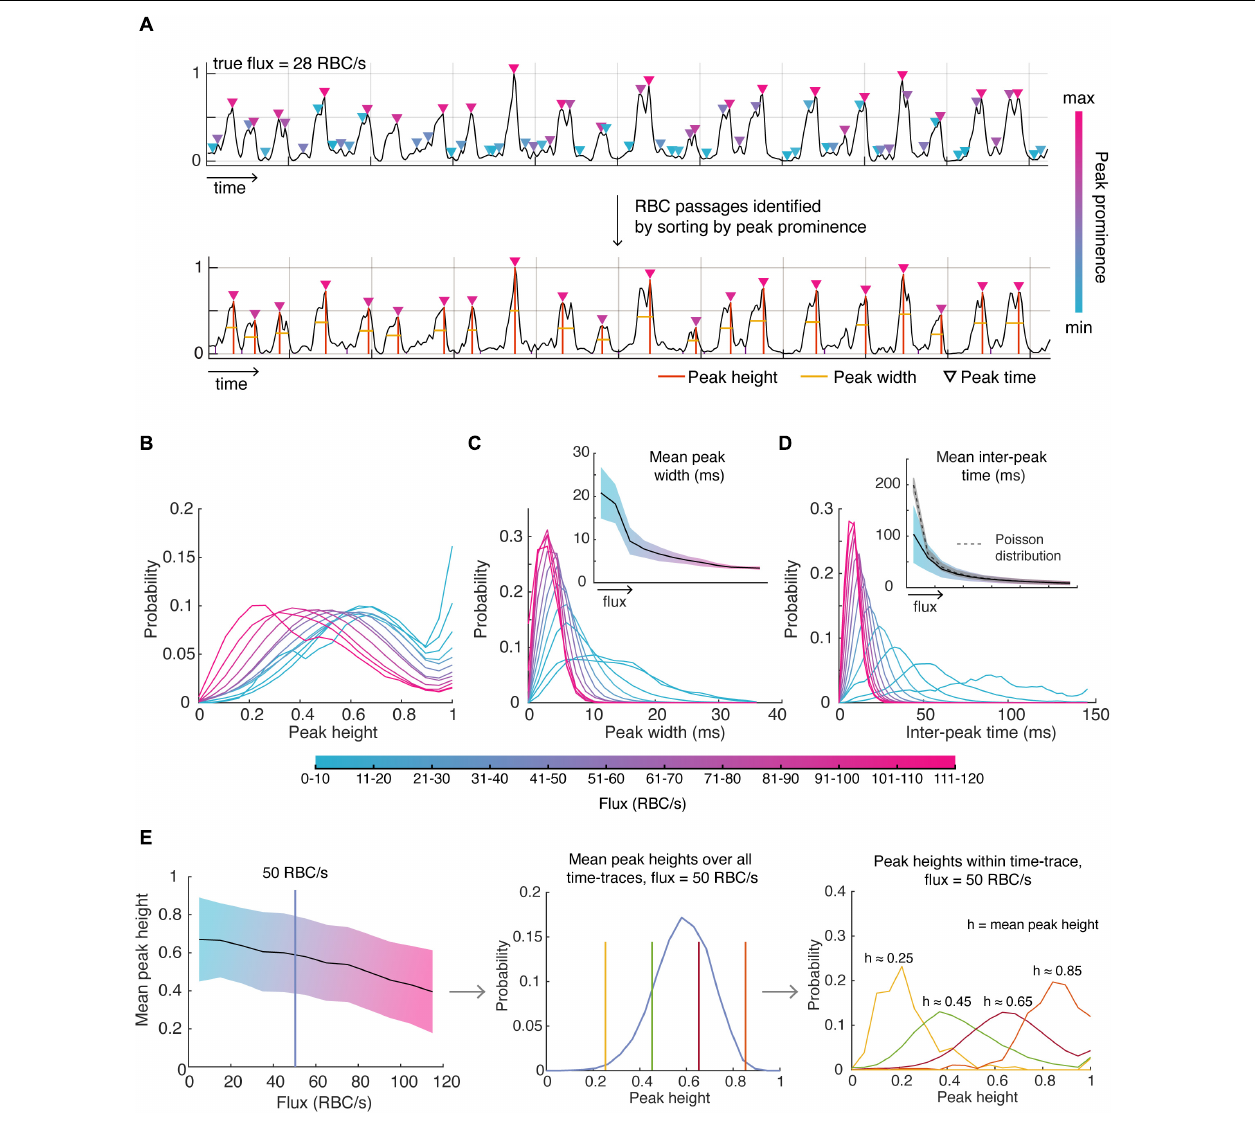
FIGURE 2 | Detecting RBC passages from OCT time-series data and characterizing the distributions of parameters describing these RBC passages. (A) RBC passages were identified using the known value of flux (obtained by TPEF) and sorting peaks based on peak prominence. Orange lines describe peak position and heights, and the yellow line is the full width half maximum (FWHM), describing the width. (B) The distribution of all peak heights (C) peak widths and (D) inter-peak times for varying ranges of flux values. (E) Mean peak height decreases with increasing flux (left). Mean peak height over all time-traces for each flux category is described by a beta distribution (middle) as shown using 50 RBC/s as an example, and the peak heights within a time-trace given the mean peak height are also described by the beta distribution (right). Shaded areas show the standard deviation about the